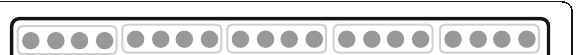
Fig. 2 Twenty as a composite unit made up of 5 composite units of